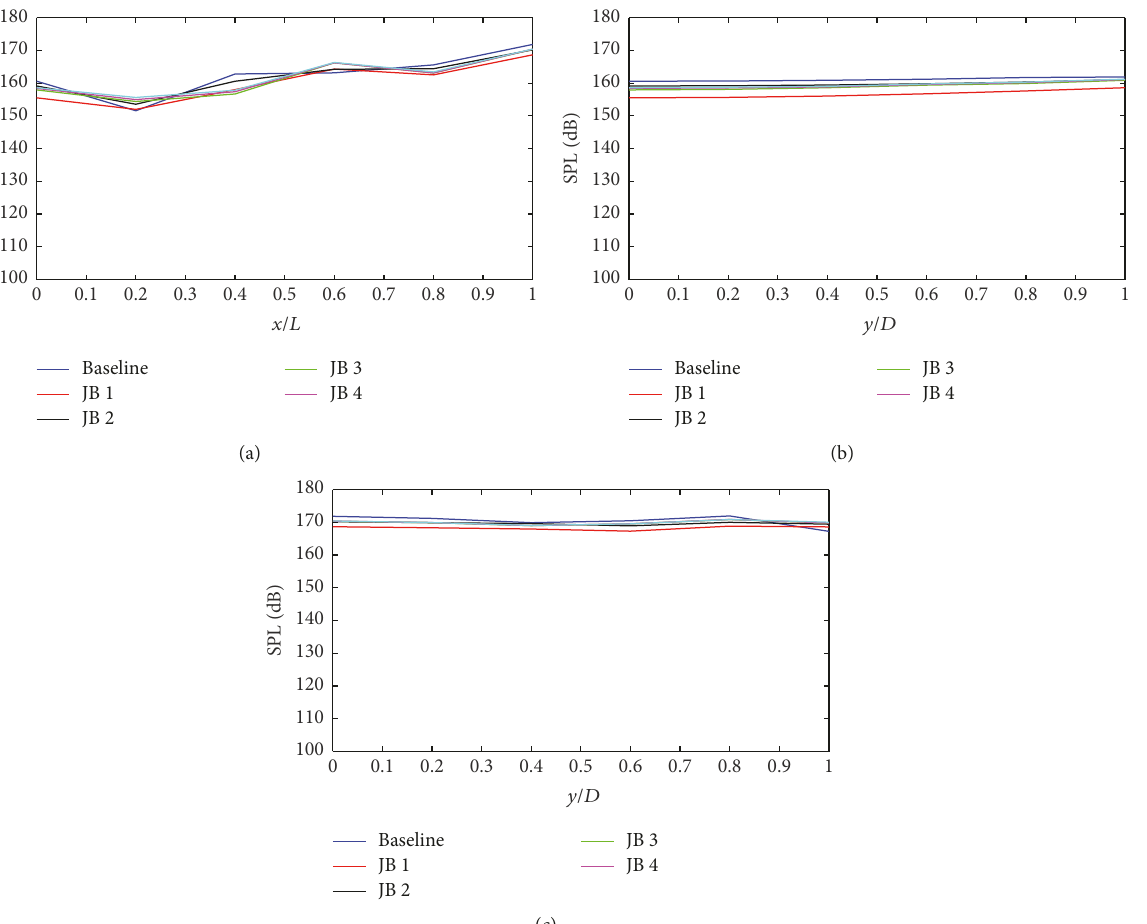
Figure 29: SPL values for (a) bottom wall, (b) leading edge wall, and (c) trailing edge wall for active control